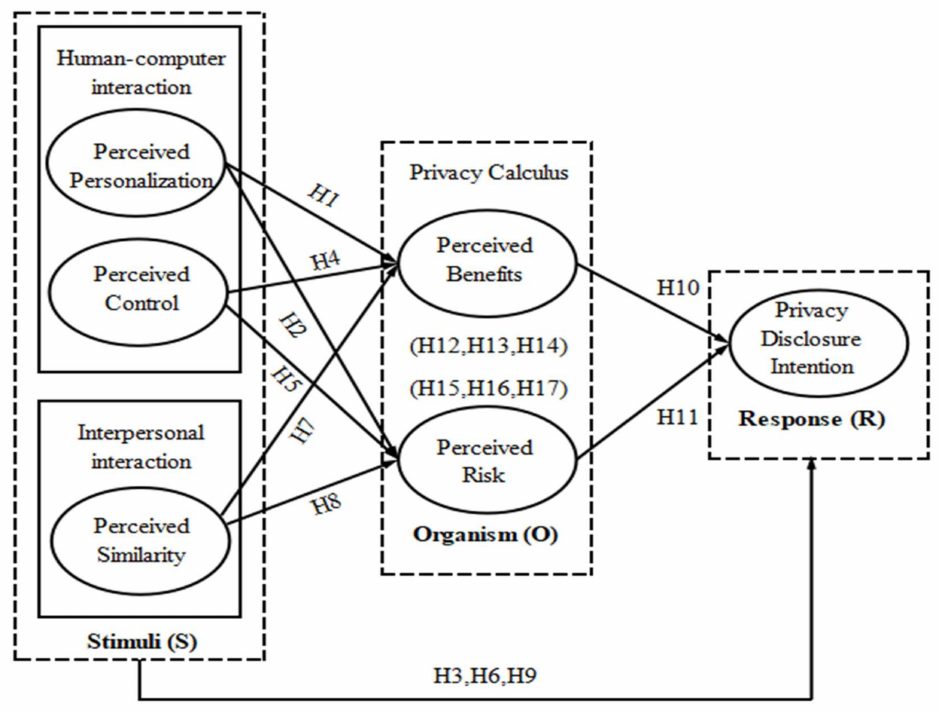
Figure 1. Research